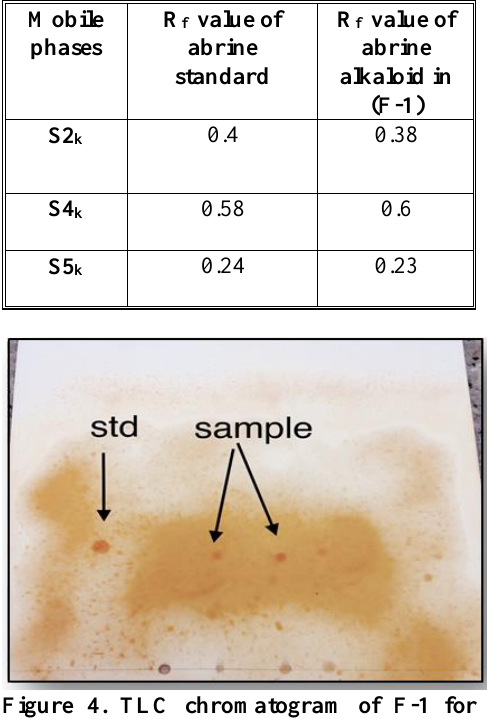
Table 4. The R f values of abrine alkaloid in (F-1) in Abrus precatorius extract, and standard in different developing solvent systems using TLC.